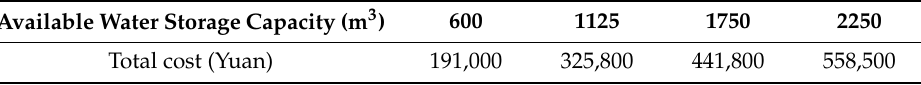
Table 4. Water storage capacities and total costs of di ff erent